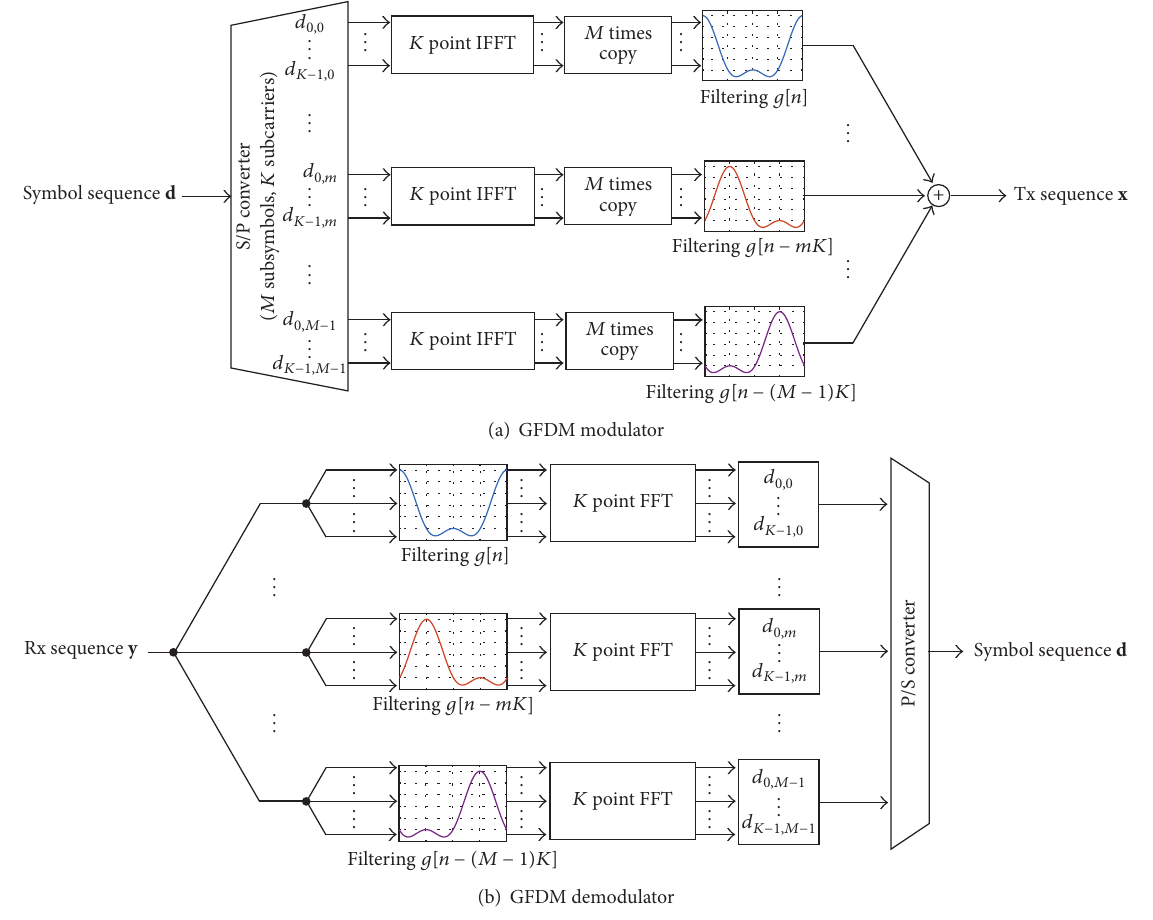
Figure 15: GFDM modulator and demodulator